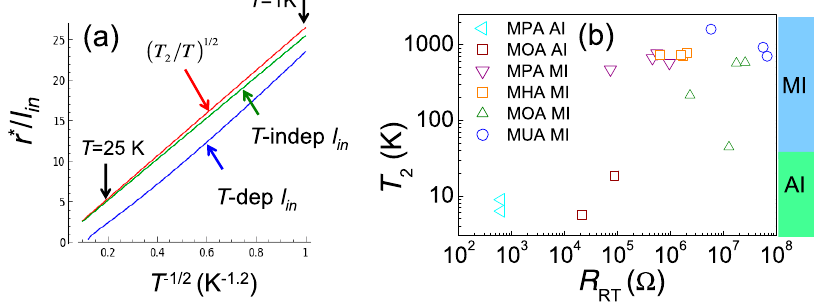
Figure 4. ( a ) hopping exponent ( r * / l in ) vs. T − 1/2 plots for temperature-dependent l in using Equation (10) (blue), and temperature-independent l in = 0.1 a (green). The red curve is a function plot, ( r * / l in ) = ( T 2 / T ) 1/2 with T 2 = 700 K. The slopes of all curves are very similar; ( b ) a summary of T 2 values for insulating devices. Clearly, the devices can be divided into two categories. Devices with R RT larger than 10 5 Ω have T 2 larger than ~ 100 K.